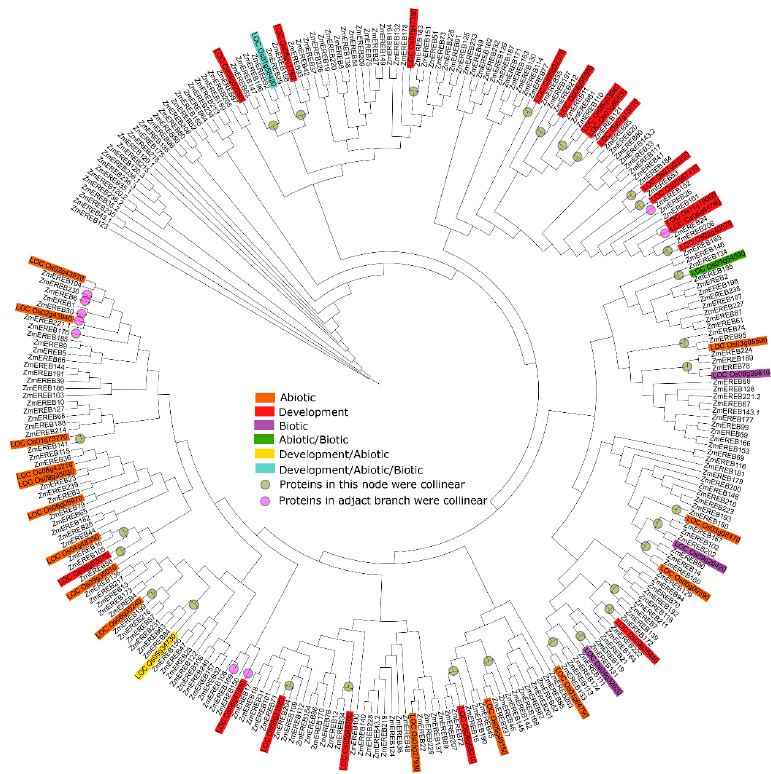
Figure 1. The phylogenetic tree of AP2/ERFs in maize and rice using MEGA11 software based on the neighbor-joining method. All members in maize and rice-cloned AP2/ERFs were subjected to construct the tree, and the bootstrap value was set as 1000. The rectangular box with different colors represented the development and stress processes that involved by rice AP2/ERFs, and the circle with different colors represented the collinear relationship of AP2/ERFs between rice and maize.